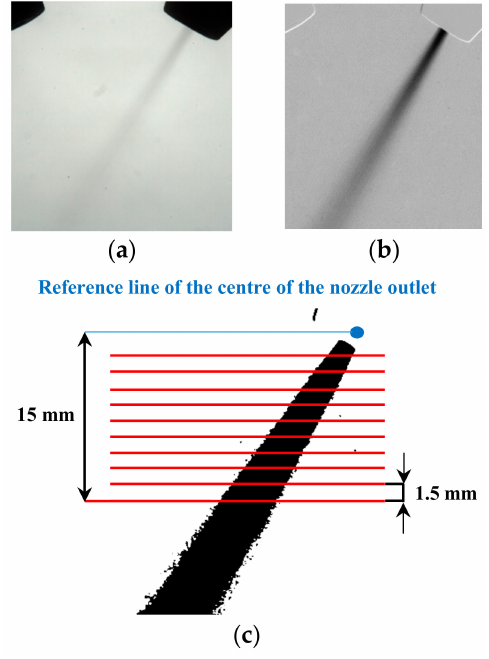
Figure 4. (a ) Acquired image; ( b ) acquired image after subtracting the background; ( c ) evaluation planes on the image filtered by